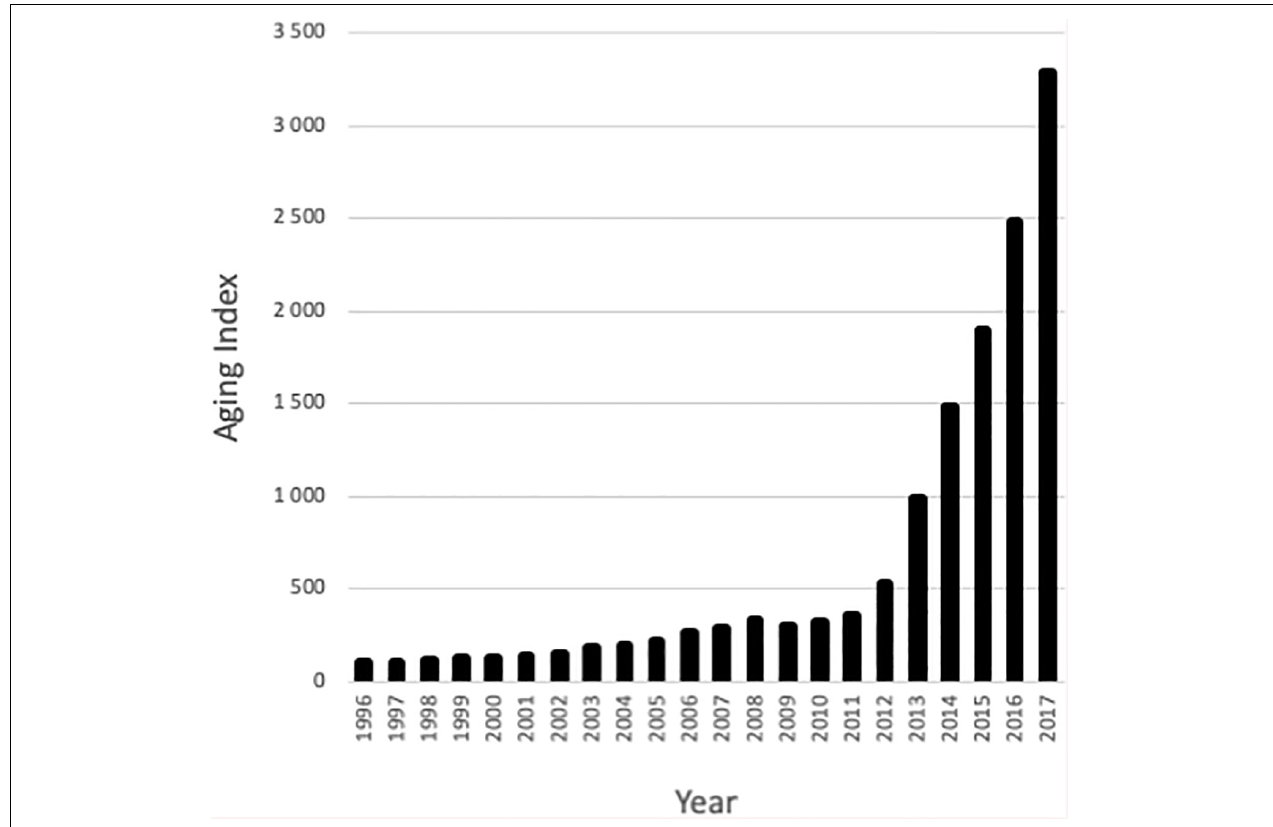
FIGURE 1 | Aging index (no. of teachers with more than 50 years/no. teachers with less than 35 years × 100). Source: Pordata (https://www.pordata.pt/DB/Portugal/Ambiente+de+Consulta/Tabela, assessed in